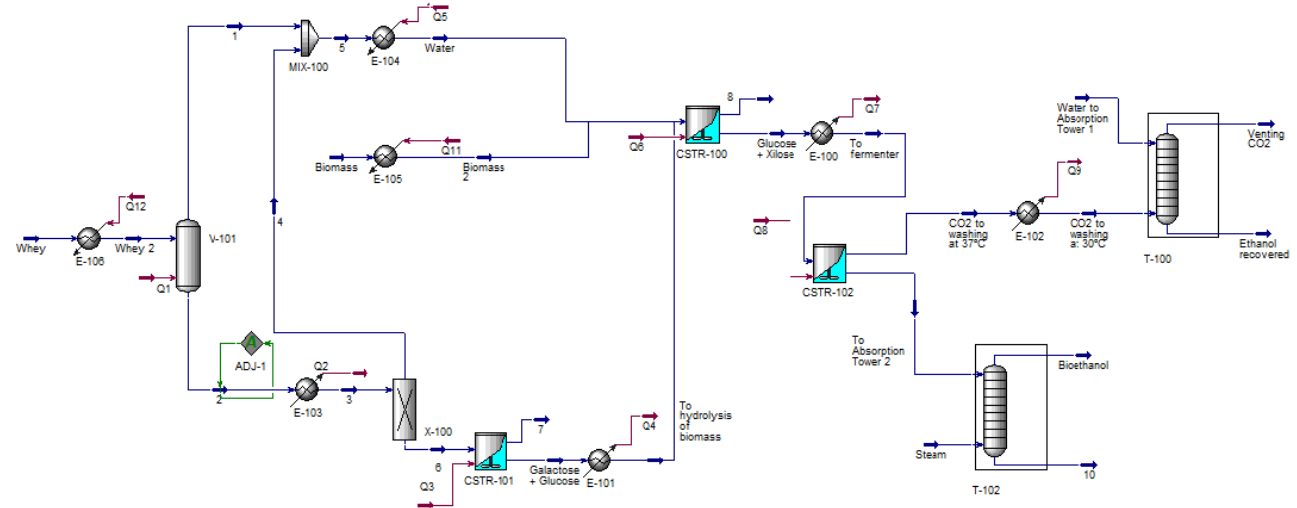
Fig. 1. Flowsheet of the bioethanol production process from rice husks and